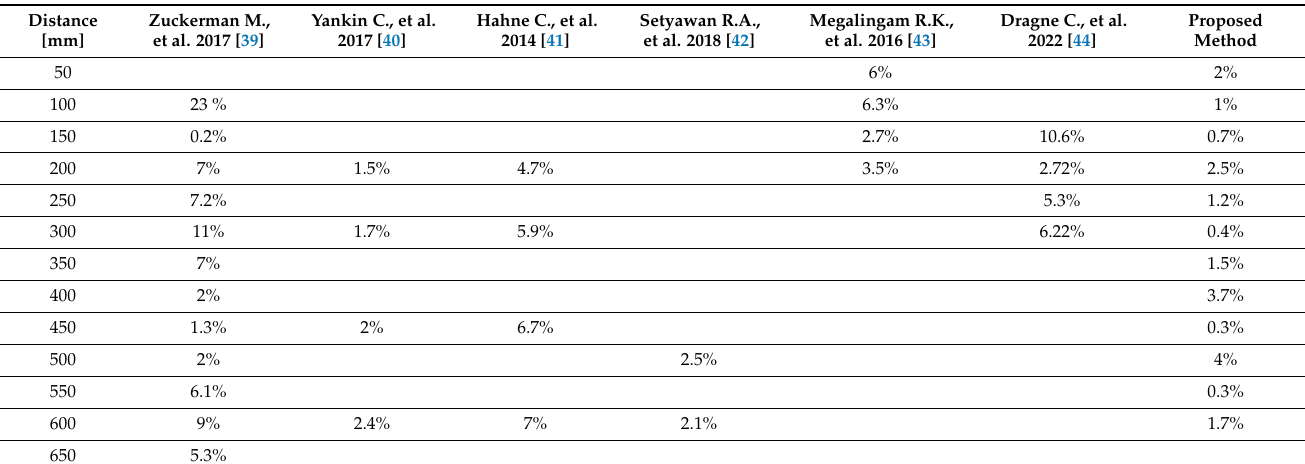
Table 2. The relative error in video distance measurement.